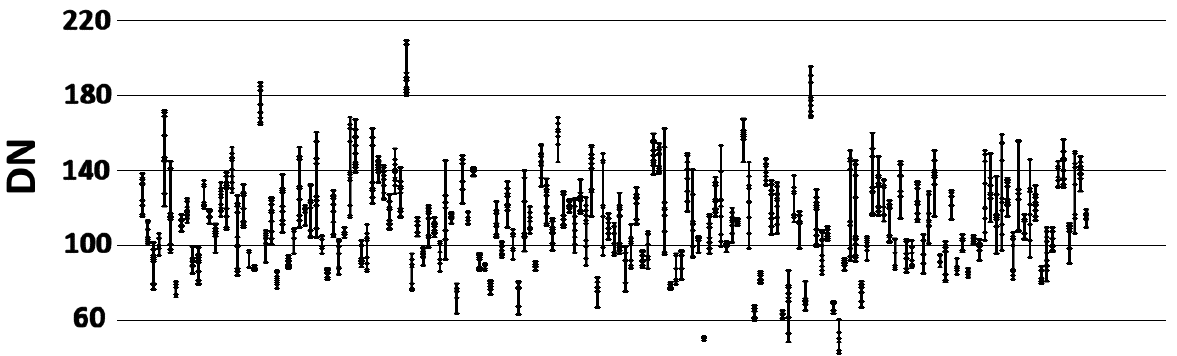
Figure 9. RED band values (5–12 images per sample) of HO sample plots. The vertical line joins the observations of images that 'view' the sample plot. The target effect for HO on RED band was 83 %, which is reflected by the clustering in the